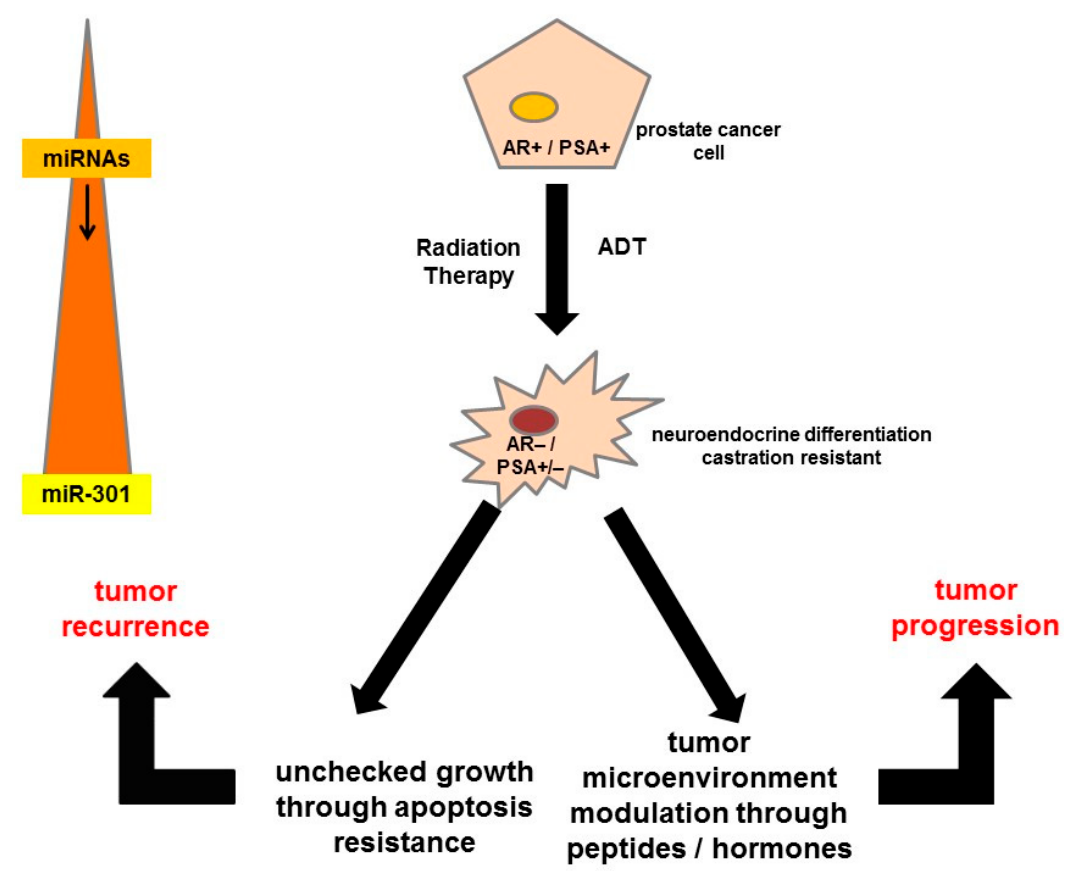
Figure 2. High heterogeneity among patients with metastasized CRPC after multiple different therapies at the stage when they are referred for Lu-177-PSMA therapies. The diagram gives a short overview of the different potentially activated signaling pathways on progression of prostate cancer cells that might become androgen-receptor- and prostate-specific antigen-negative over time, which can lead to apoptosis resistance and tumor recurrence or progression. ADT = androgen deprivation therapy, AR = androgen receptor, miRNA = microRNA, PSA = prostate-specific antigen.